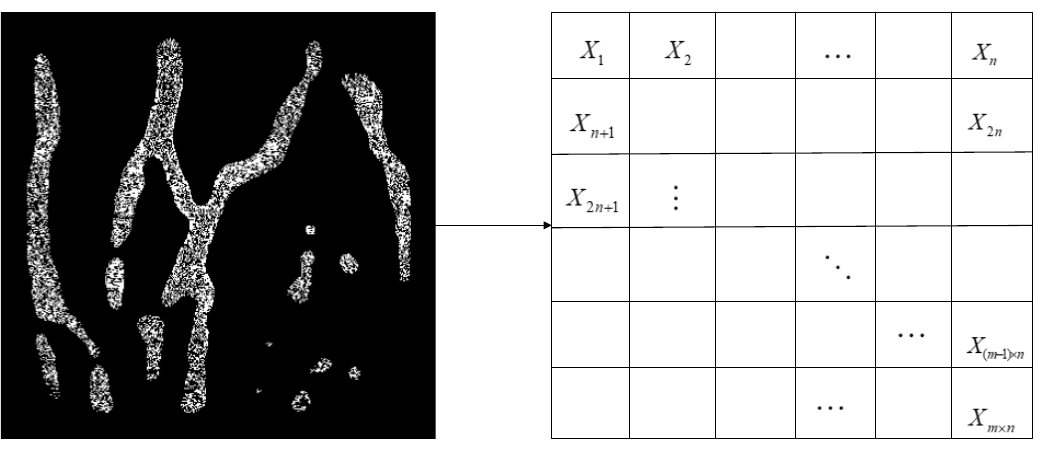
Figure 9. Divide image into blocks.